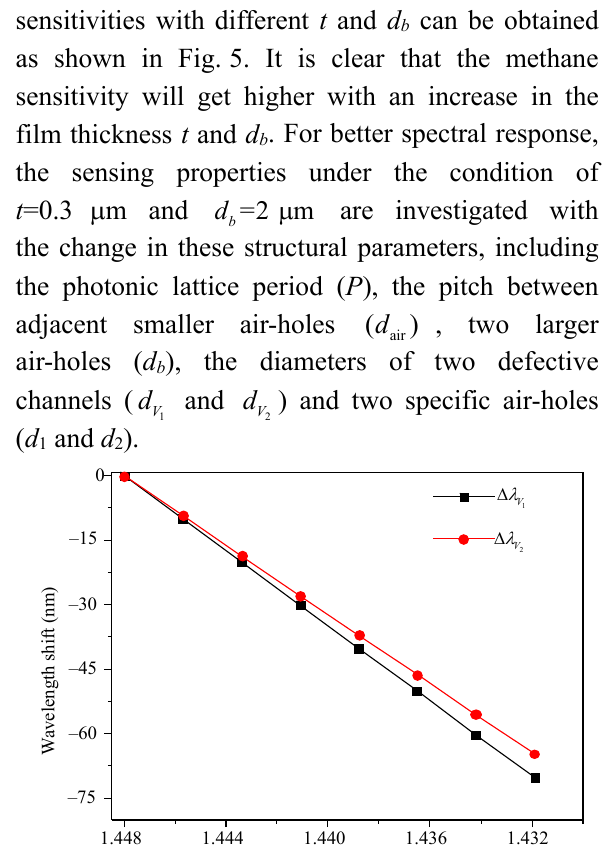
 at different t , (b1) 2 V